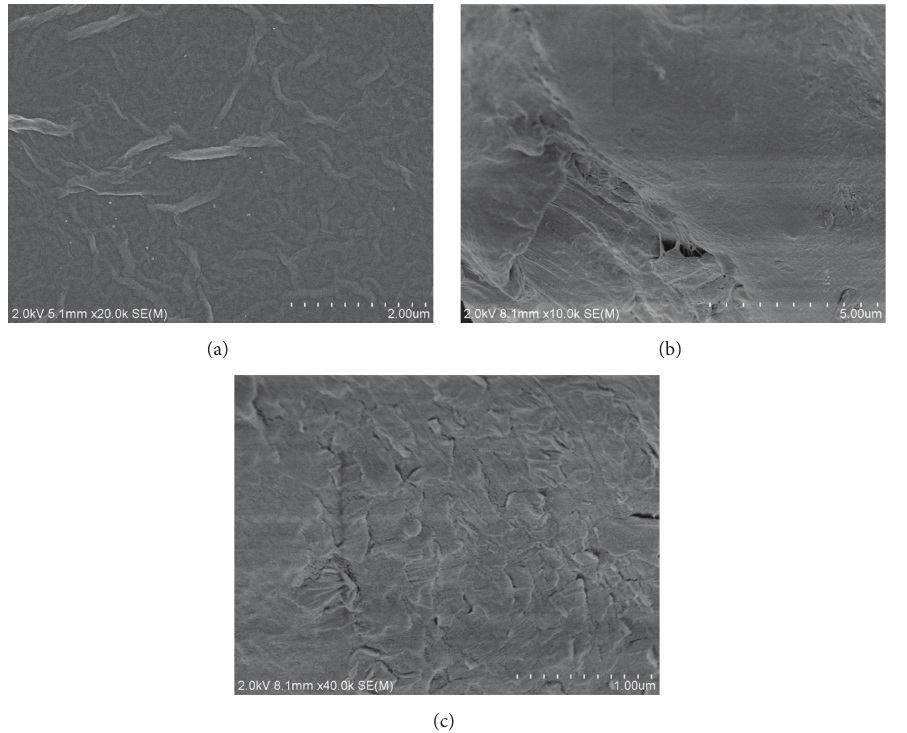
Figure 2: The SEM images of (a) GO, (b) UHMWPE, and (c) GO/UHMWPE